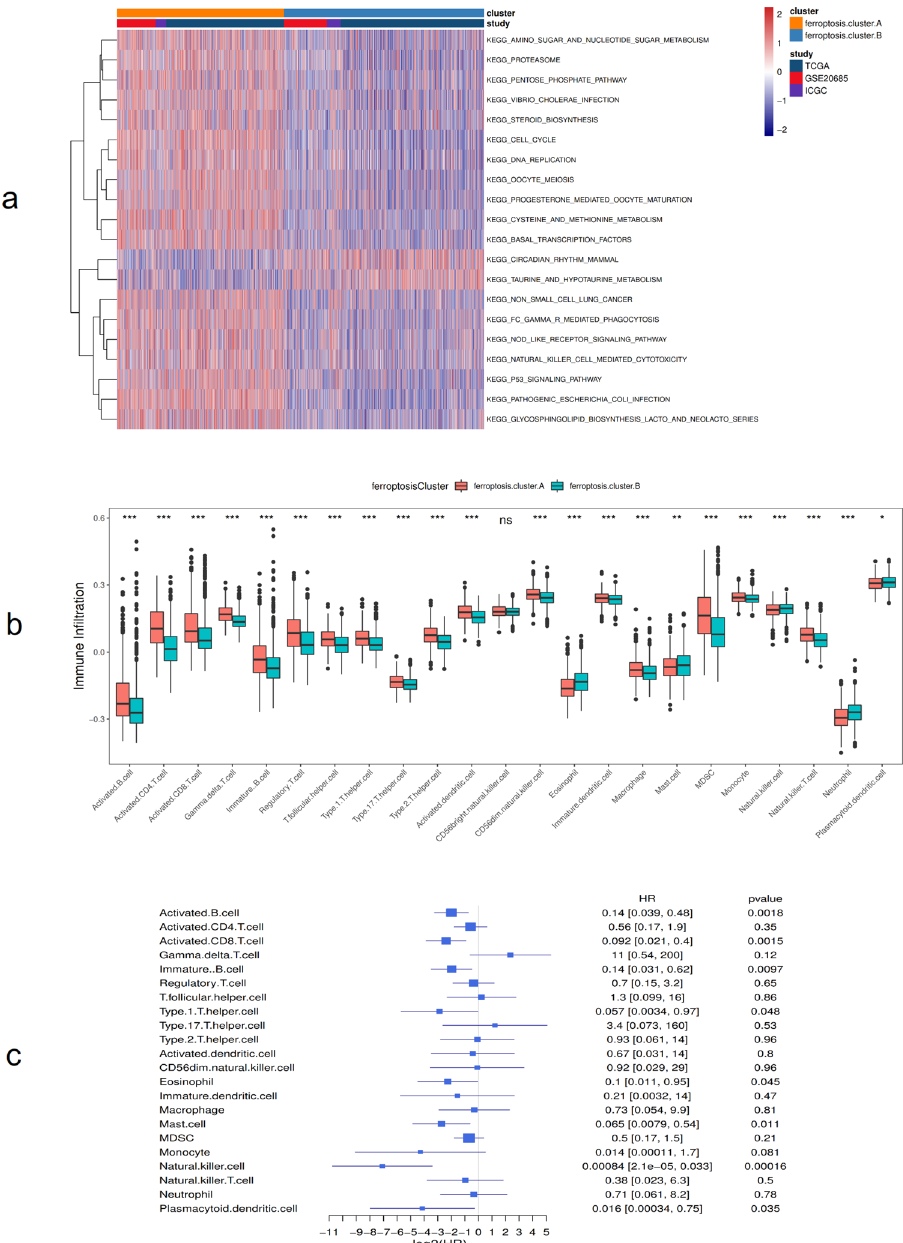
Figure 2. Biological behavior among ferroptosis expression patterns. ( a ) Gene Set Variation Analysis (GSVA) enrichment analysis results (different ferroptosis clusters show the activation status of biological pathways. Red indicates activation and blue indicates inhibition). * p < 0:05, ** p < 0:01, and *** p < 0:001; ( b ) The distribution of immune infiltration of 23 kinds of immune cells in different ferroptosis clusters; ( c ) Prognosis analysis of differential